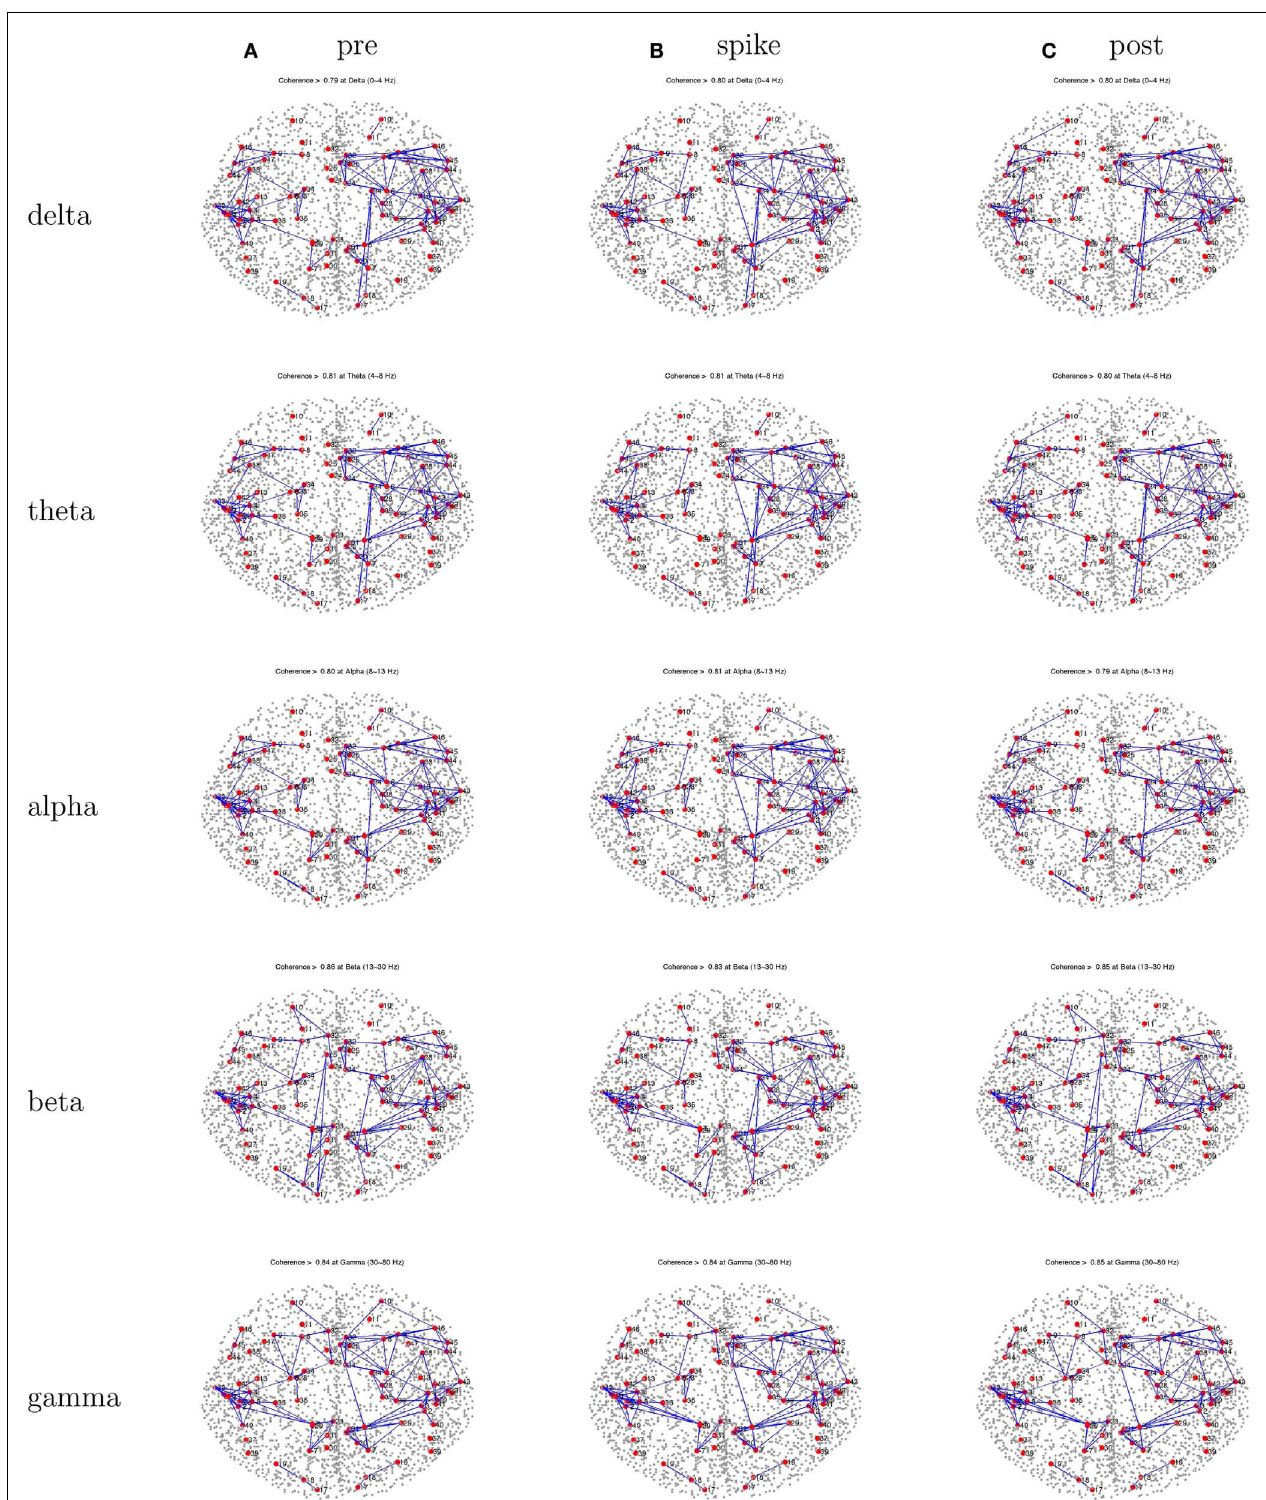
FIGURE 8 | Patient 3’s dEEG cortical source coherence peaks (highest 100 of ∼ 6400) for pre-spike (A), spike (B), and post-spike (C) intervals of the five frequency bands .